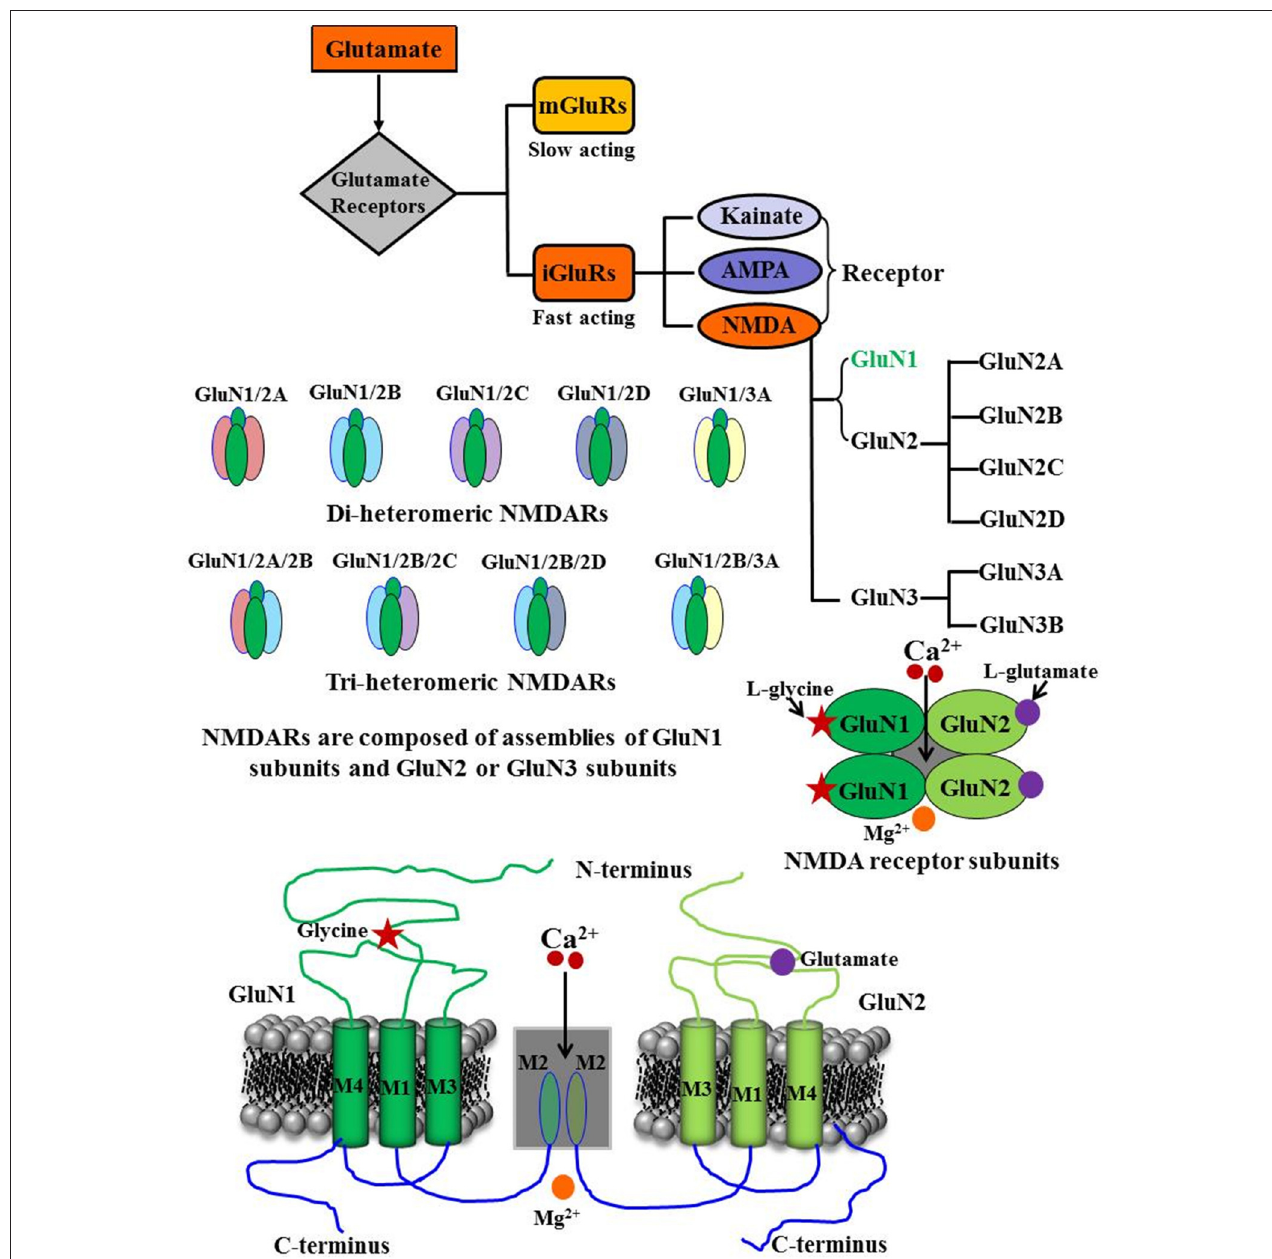
FIGURE 1 | Schematic model of the NMDA receptor and its subunit configuration. NMDA receptors represent one of the inotropic glutamate receptors, which are composed of assemblies of GluN1 subunits and GluN2 and or GluN3 subunits. Functional NMDA receptors are composed of two GluN1 subunits and two GluN2A-D subunits; GluN3 subunits (GluN3A and GluN3B), without involving other GluN2 subunits, can assemble with GluN1 subunits to form active receptor. GluN1 subunits carry the co-agonist glycine binding site while glutamate binds to GluN2 subunit. Mg 2 + blocks the Ca 2 + permeable pore. All of these subunits of NMDA receptor share a common membrane topology, a large extracellular amino-terminal domain, three transmembrane segments (M1, M3, and M4), a re-entrant pore loop (M2), and an intracellular cytoplasmic C terminal domain.